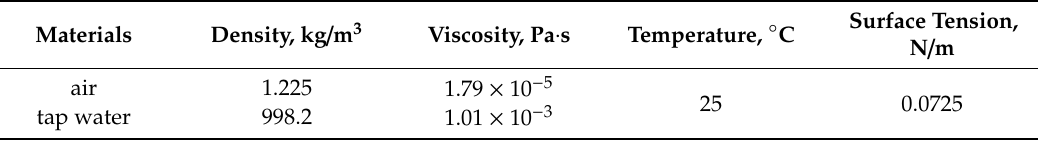
Table 3. Details of the physical properties and environmental